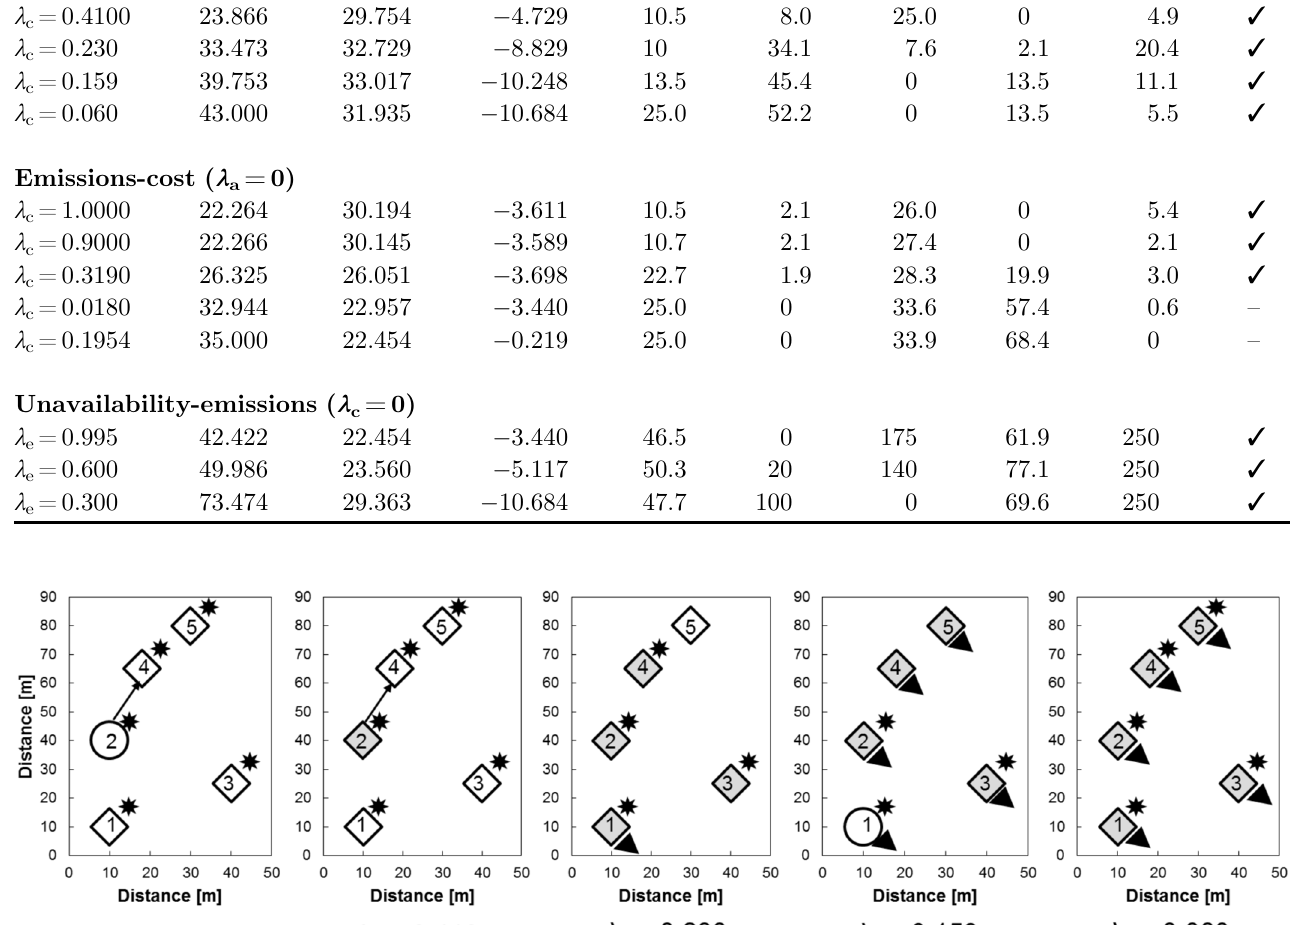
Table 2. Objective values, total neighbourhood installed unit capacities [kW or kWh (EST)], and microgrid existence (MG) for selected λ -values for each bi-objective trade-off. A total airco capacity of 11.2 kW is installed in all cases. C TOT,S EM S UA TOT,S λ = 1.000 c λ = 0.230 c λ = c